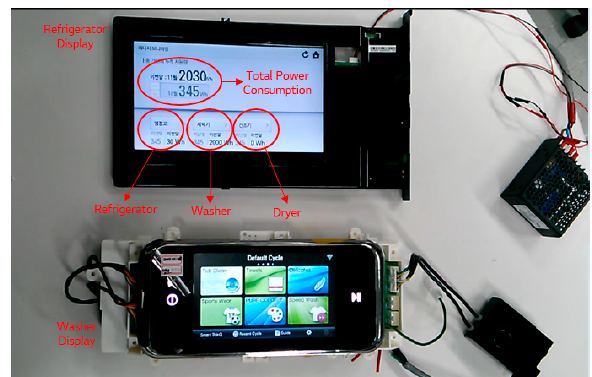
Figure 9. Experimental setup for remote monitoring of power level.